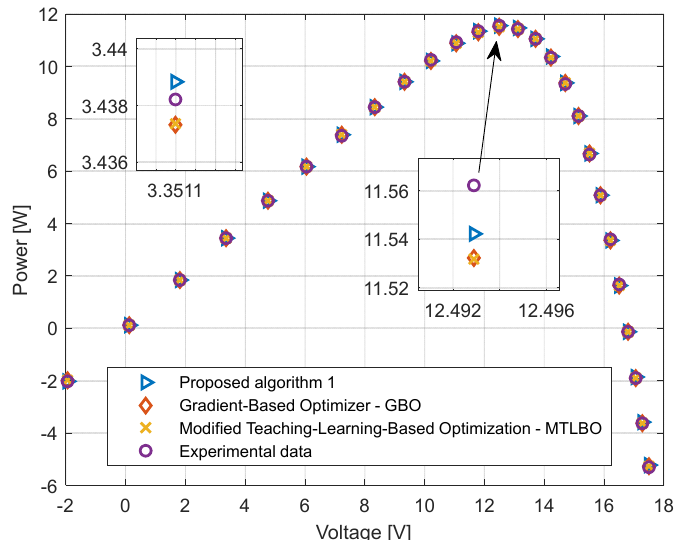
Figure 10. Power-voltage characteristics of the Photowatt-PWP201 module.